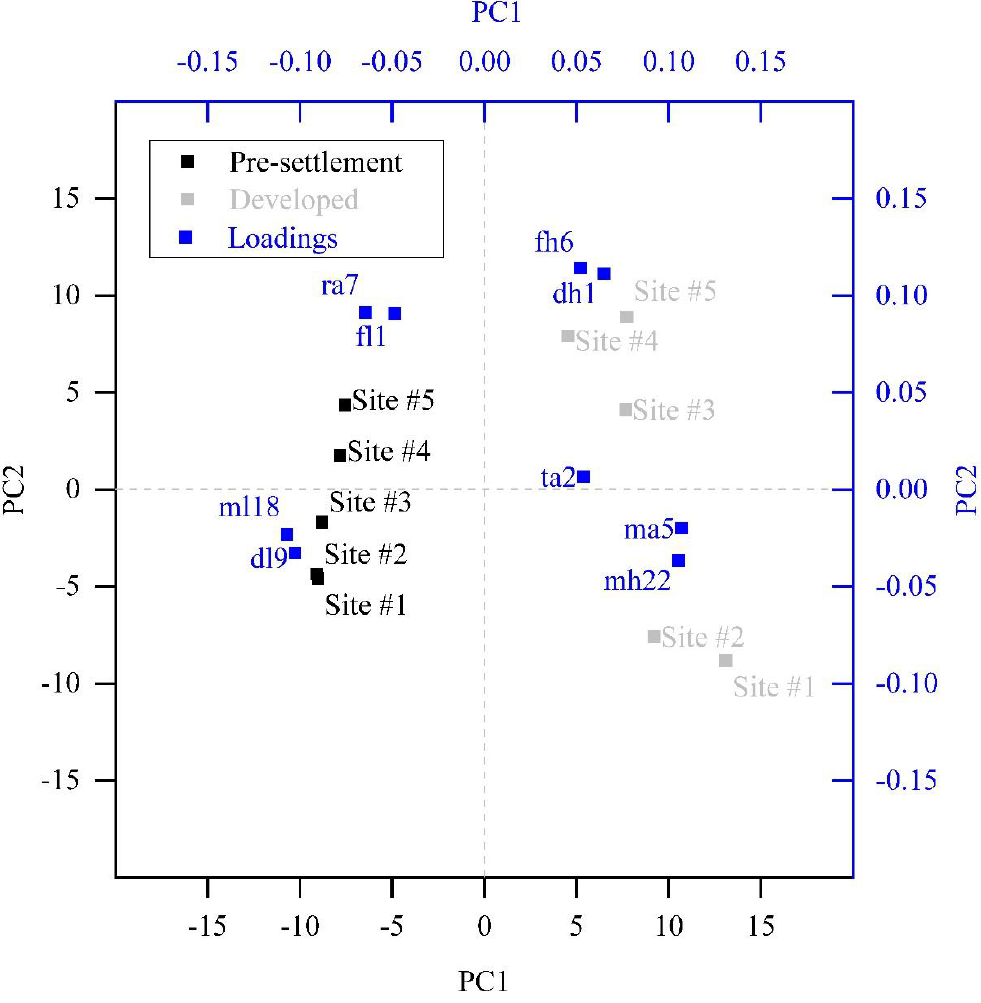
Figure 4. Biplot showing scores generated from simulated pre-settlement and observed developed flow data at five gauging sites in Hinkson Creek, MO, USA. Loadings of hydrologic indices with the greatest absolute loadings for nine flow elements are also shown. PC1 and PC2 are principal component axes. Definitions of hydrologic indices are shown in Table 2.